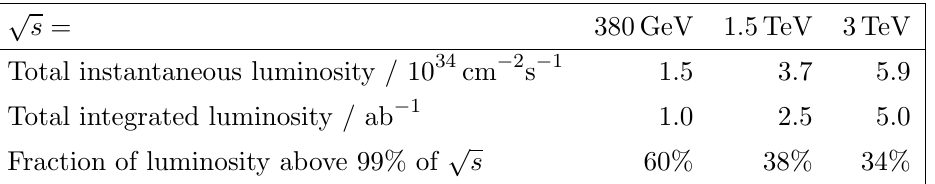
Figure 1. The luminosity spectra for CLIC operating at denotes the ratio of the e(cid:11)ective centre-of-mass energy after beamstrahlung, centre-of-mass energy